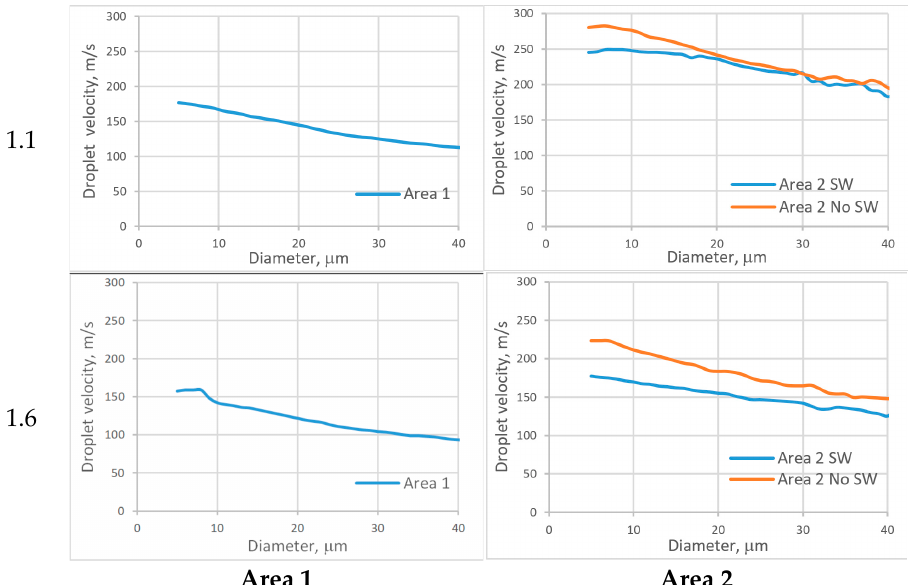
Figure A4. Velocity distribution by droplet diameters, gas flow Mach number M = 2. The left column shown water injection pressure p l , MPa.